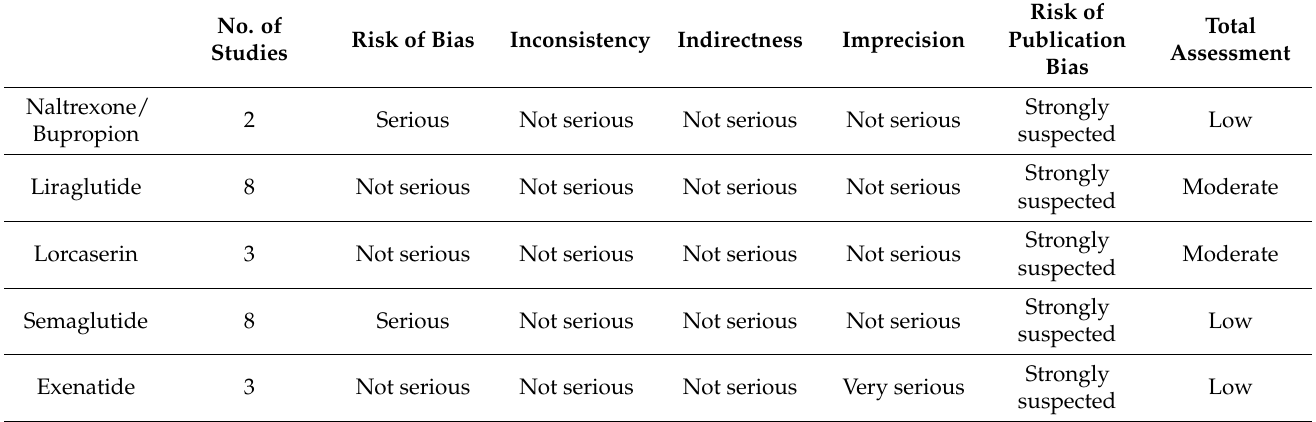
Table 3. Assessment of quality using the academic version of GRADEpro tool.